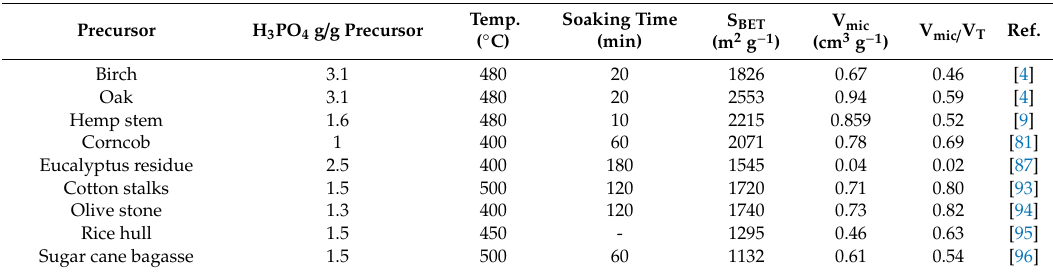
Table 7. Summary of optimal experimental conditions in terms of porosity development of ACs produced by H 3 PO 4